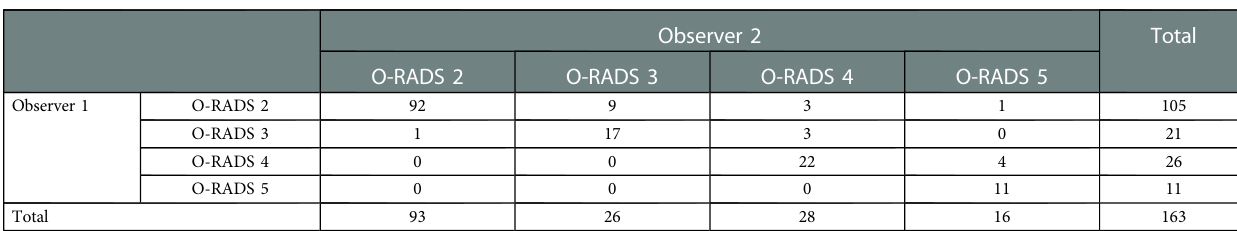
TABLE 5 Inter-observer agreement of O-RADS classi fi cation.